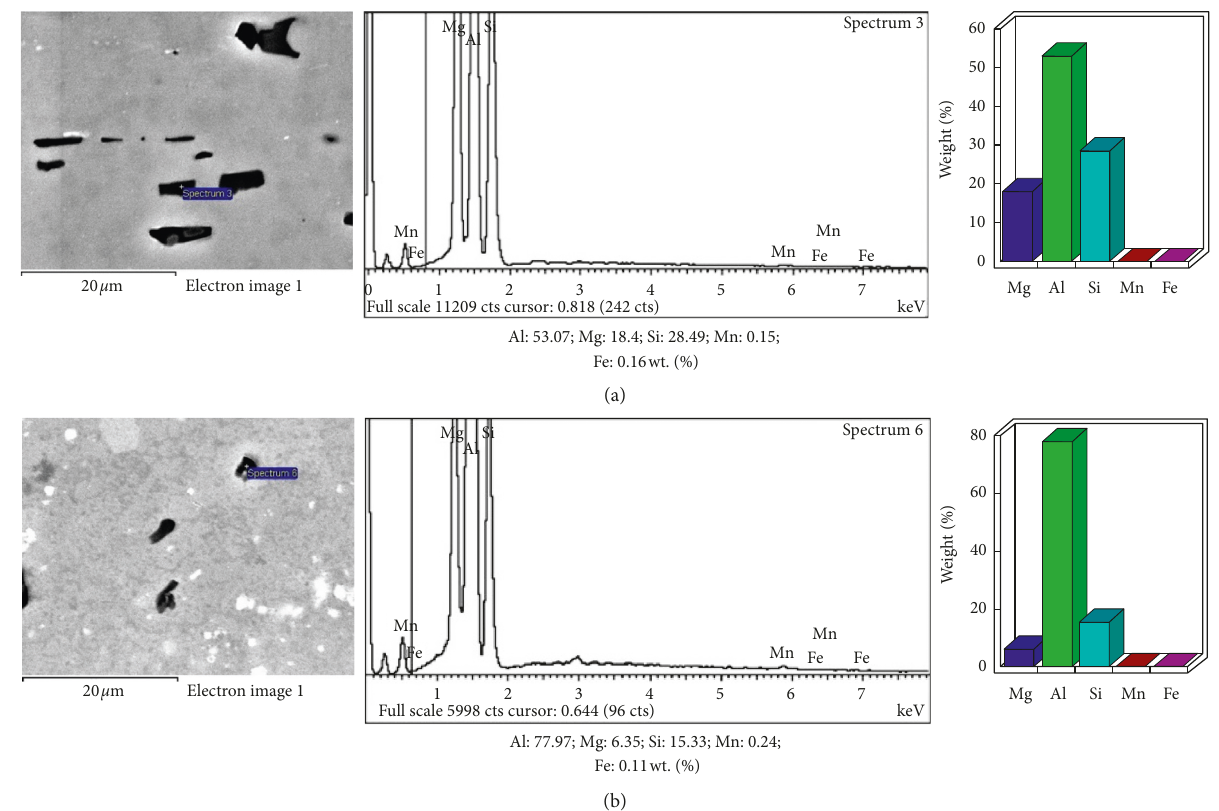
Figure 8: High magnification EDS elemental analysis of the second phase particles present in (a) base metal and (b) stir zone.